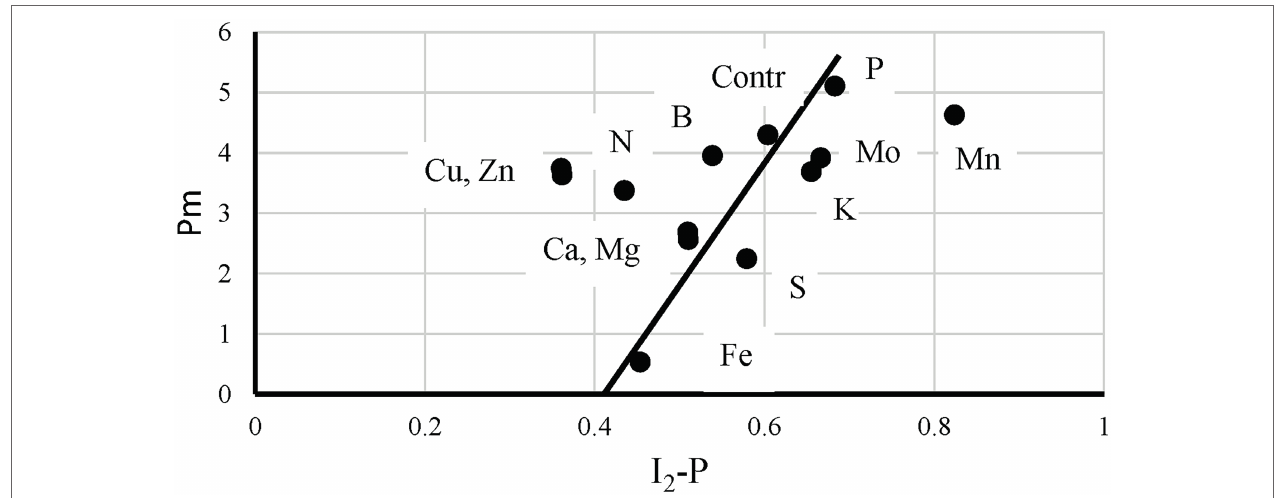
FIGURE 8 | The relationship between the P700 + (I 2 -P) and I 2 -P kinetics measured on leaves of control plants and of plants exposed to 12 mineral deficiencies. The points are averages of four independent